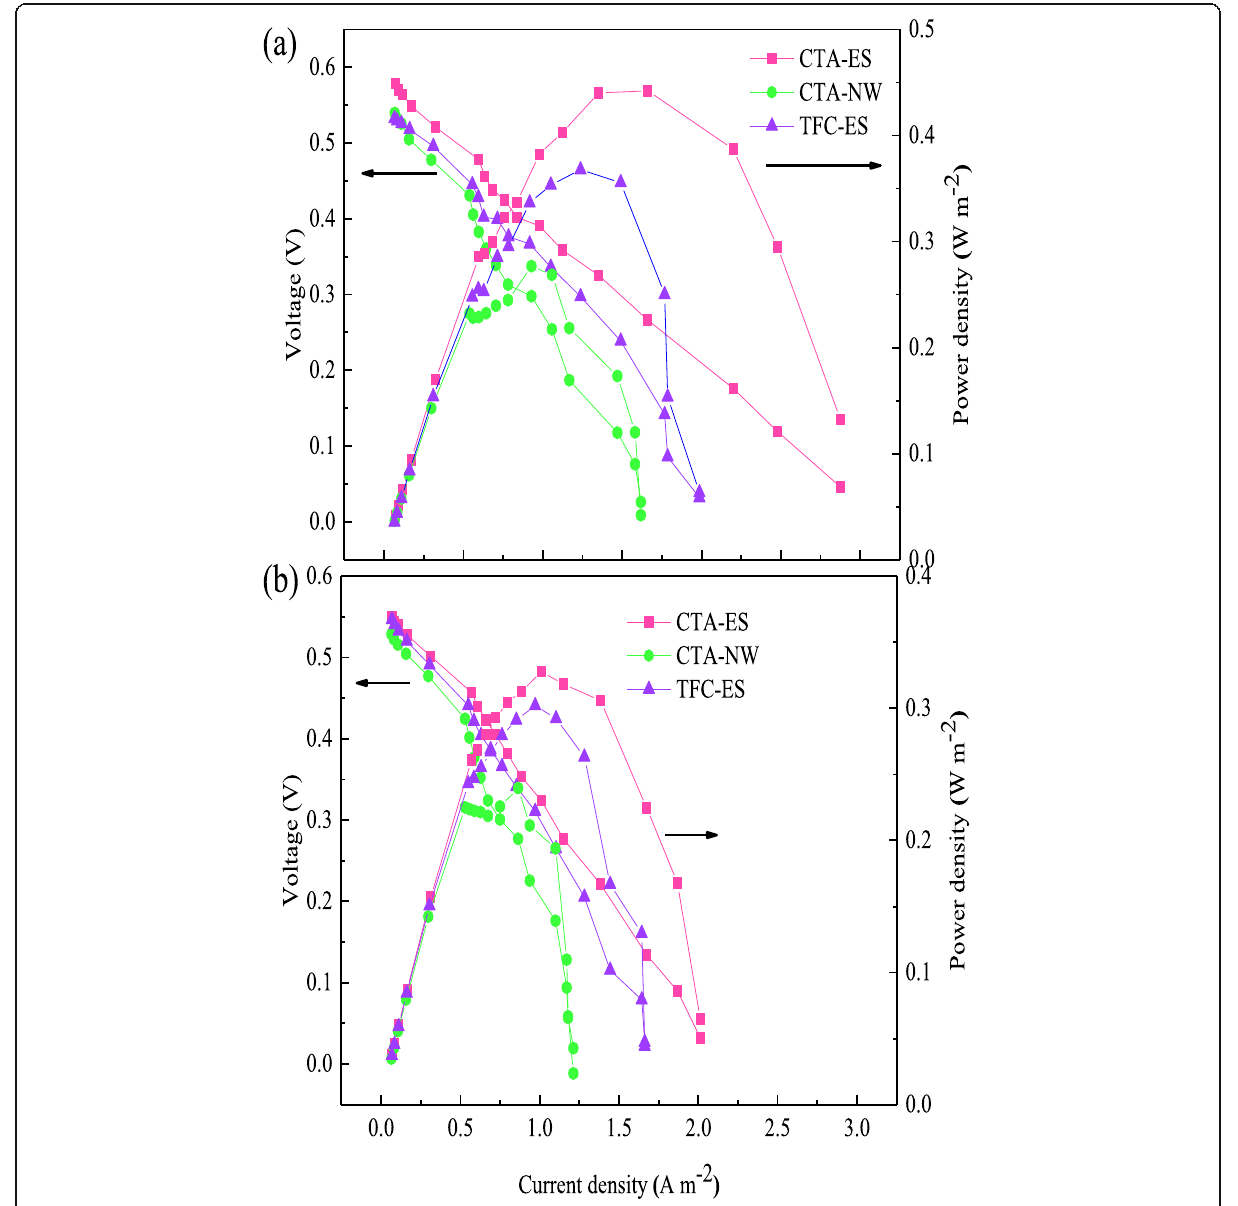
Fig. 3 The power density curves and polarization curves of OsMFCs under AL-FS mode ( a ), AL-DS mode ( b